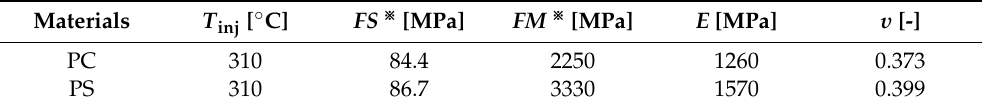
Figure 9. Nano-filler content dependence of flexural properties: ( a ) flexural strength; ( b ) flexural modulus. Table 4. Elastic properties of PC and PS.